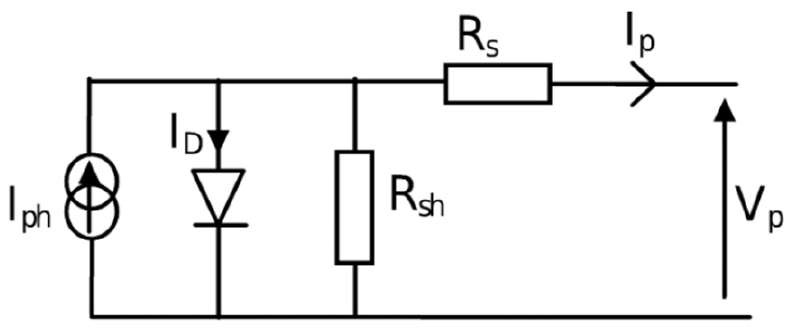
Figure 2. General circuit of a one-diode PV cell.